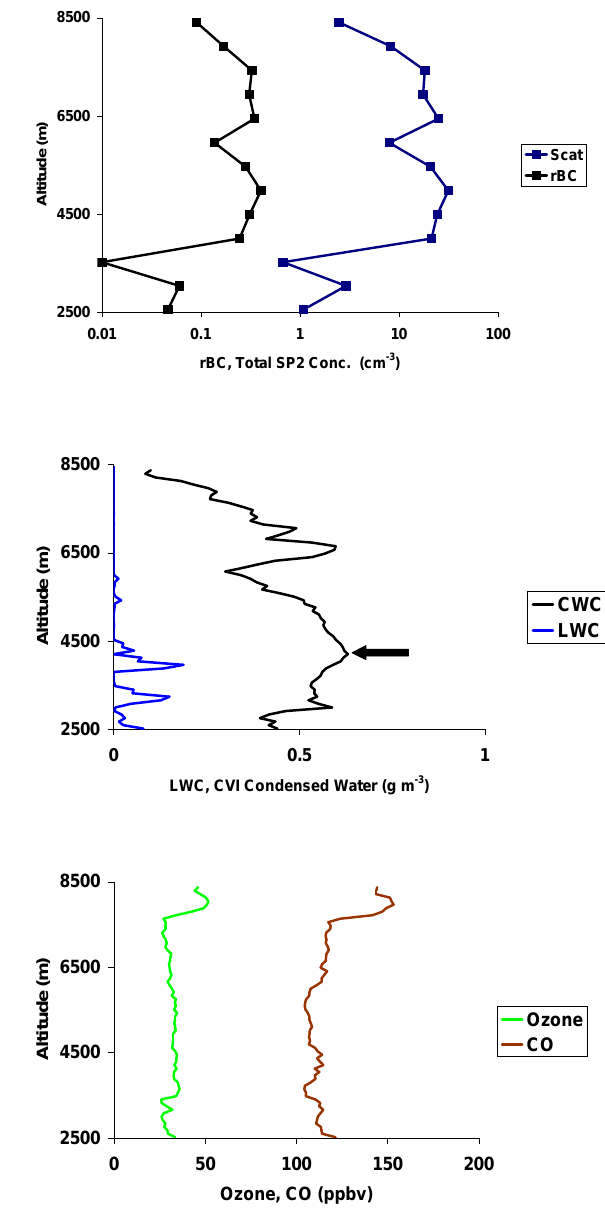
Fig. 10. Profile of warm sector cloud just above the front as in Fig. 7, but showing the SP2 total particle (Scat) and rBC number concentration (top, based on 60s averaged data taken from the CVI inlet), liquid and total water concentration (middle) and the CO and Ozone mixing ratios (bottom). The freezing level was at 4.2km altitude (arrow).